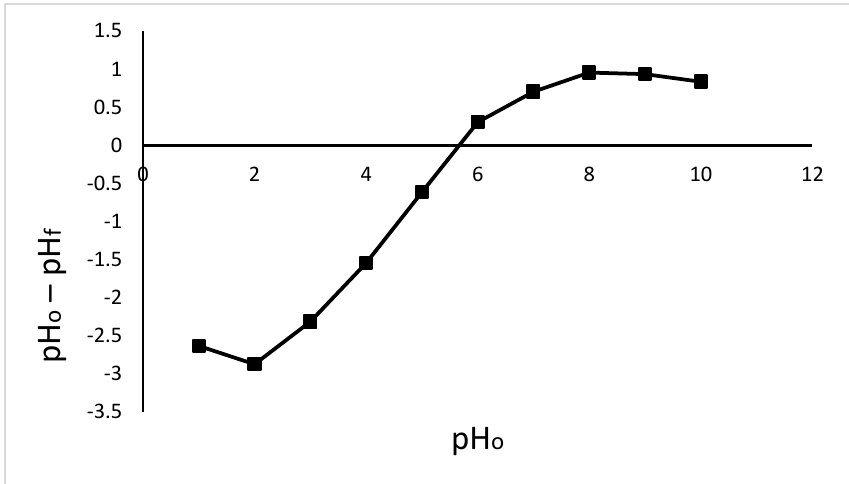
Figure 3. Point zero charge (pH pzc ) of Odaracha adsorbent .